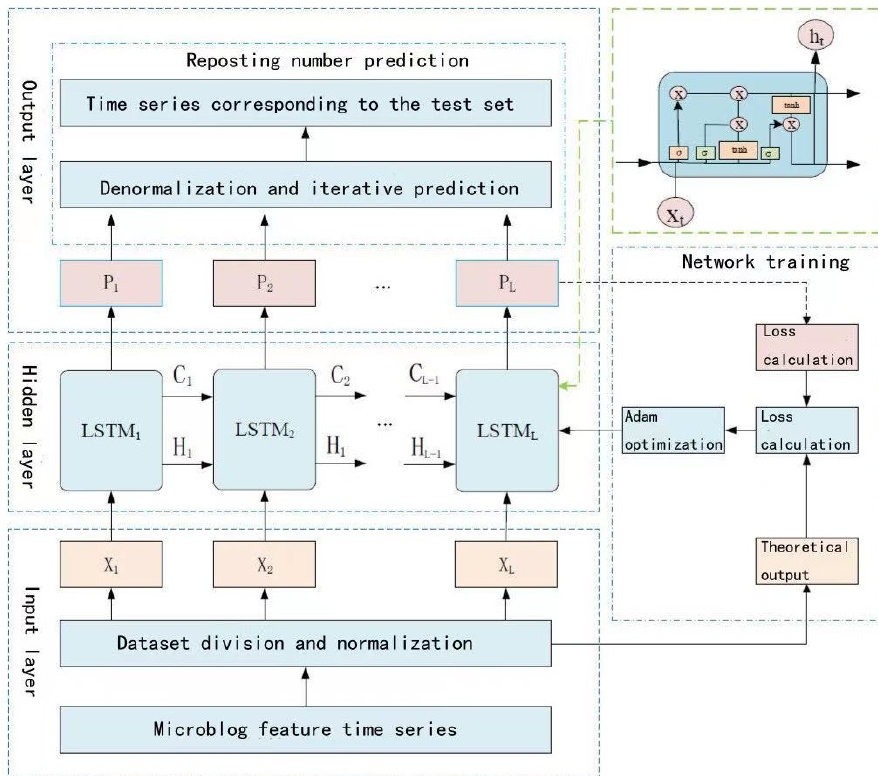
Figure 7. The framework diagram of the LSTM prediction